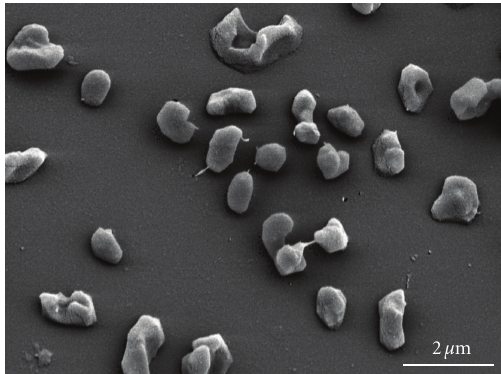
Figure 1: Scanning electron micrograph of cells of Mhp. mahii strain SLP T . Bar = 2 μ